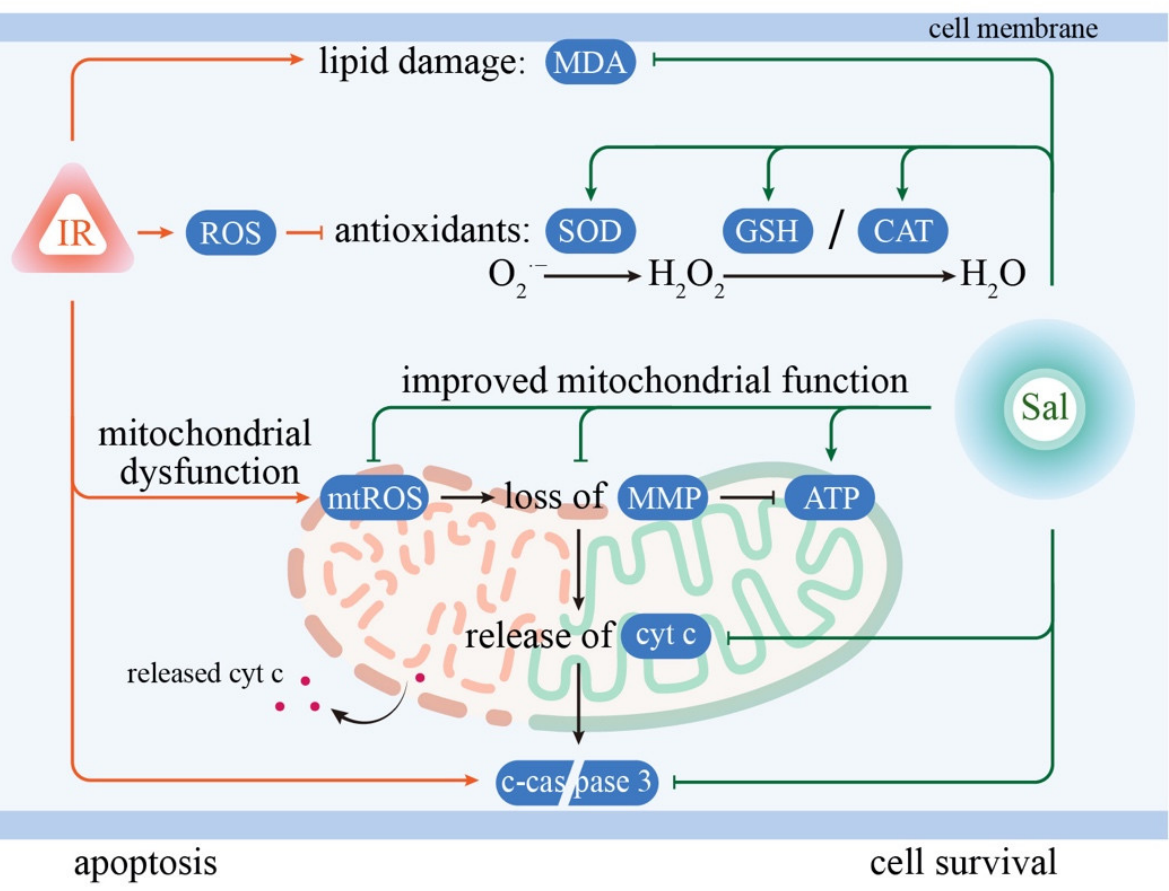
Figure 7. Schematic diagram illustrating the underlying mechanisms by which salidroside improves the survival of irradiated SMG cells against radiation damage by inhibiting oxidative injury at the mitochondrial level. Radiation induced oxidative stress damages in SMG cells, including by increasing MDA, decreasing SOD, CAT, and GSH, enhancing mitochondrial ROS, and inducing cell apoptosis. In contrast, salidroside improved the recovery of the mitochondrial ultrastructure and energy metabolism by scavenging mitochondrial ROS and improving antioxidant defense ability, which eventually led to the inhibition of cellular apoptosis in irradiated SMG cells. Abbreviations: IR, ion- izing radiation; Sal, salidroside; ROS, reactive oxygen species; MDA, malondialdehyde; SOD, su- peroxide dismutase; CAT, catalase; GSH, glutathione; mtROS, mitochondrial ROS; MMP, mitochon- drial membrane potential; ATP, adenosine triphosphate; cyt c, cytochrome c; c-caspase 3, cleaved- caspase 3.